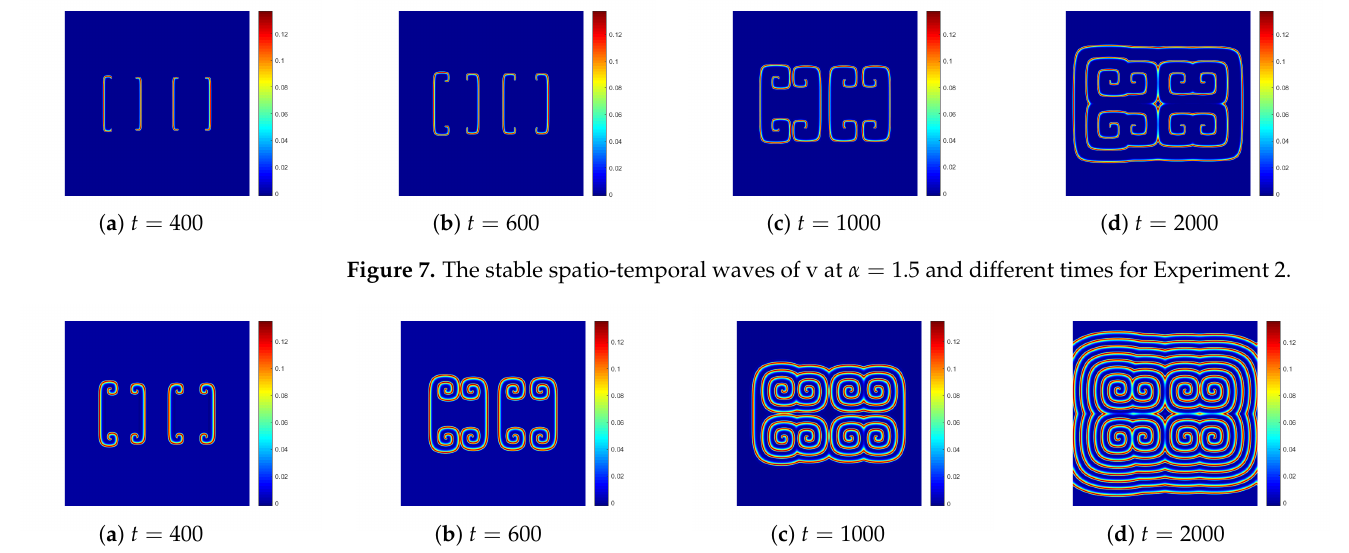
Figure 8. The stable spatio-temporal waves of v at α = 1.6 and different times for Experiment 2.